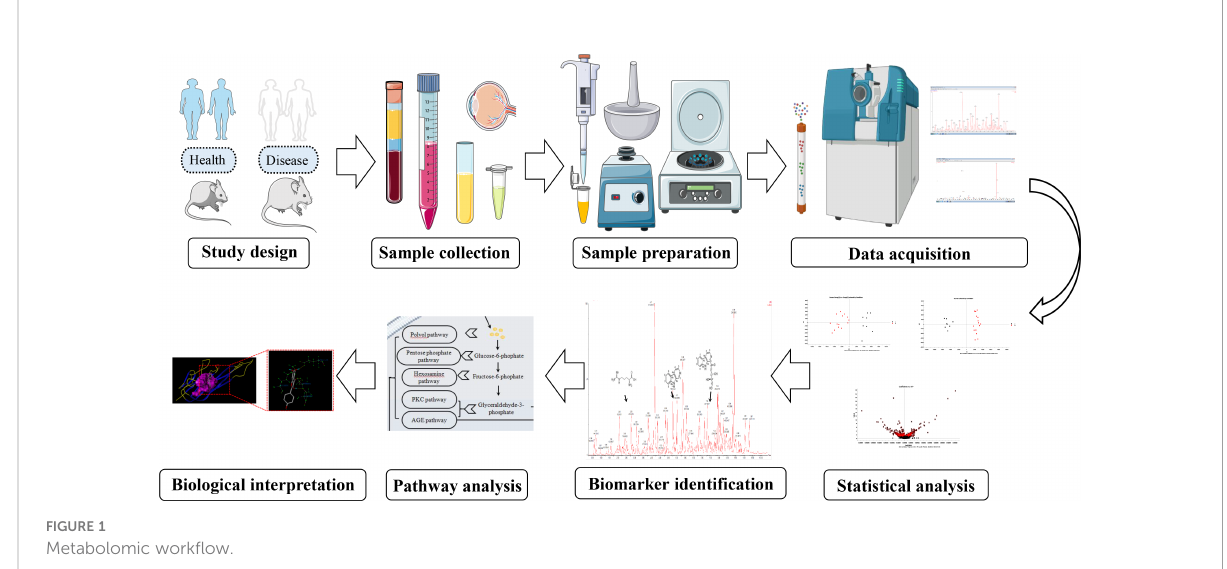
FIGURE 1 Metabolomic work fl